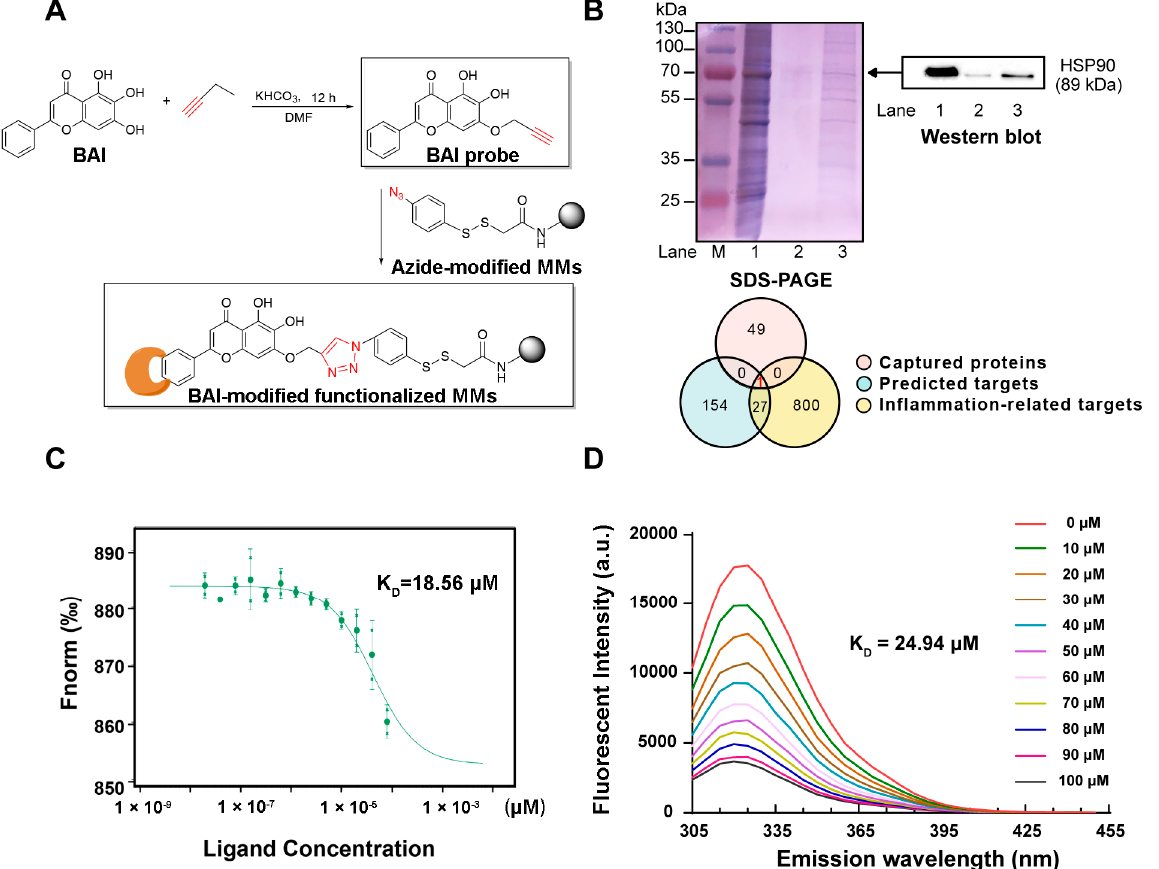
Figure 1. BAI targeted HSP90. ( A ) Synthesis of alkynyl-BAI (BAI probe) and its application in target fishing. ( B ) Identified protein targets of BAI. M: protein marker; lane 1: RAW264.7 cell lysates (loading control); lane 2: proteins captured by magnetic microspheres (negative control); lane 3: proteins captured by BAI probe modified magnetic microspheres. Integrated Venn diagram of captured proteins, predicted proteins, and anti-inflammatory proteins. ( C ) Interactions between BAI and HSP90 determined using MST. ( D ) The FQA assay of HSP90 proteins with BAI. K D is the dissociation constant. BAI, baicalein; HSP90, heat shock protein 90; MMs, magnetic nanoparticles; MST, microscale thermophoresis.